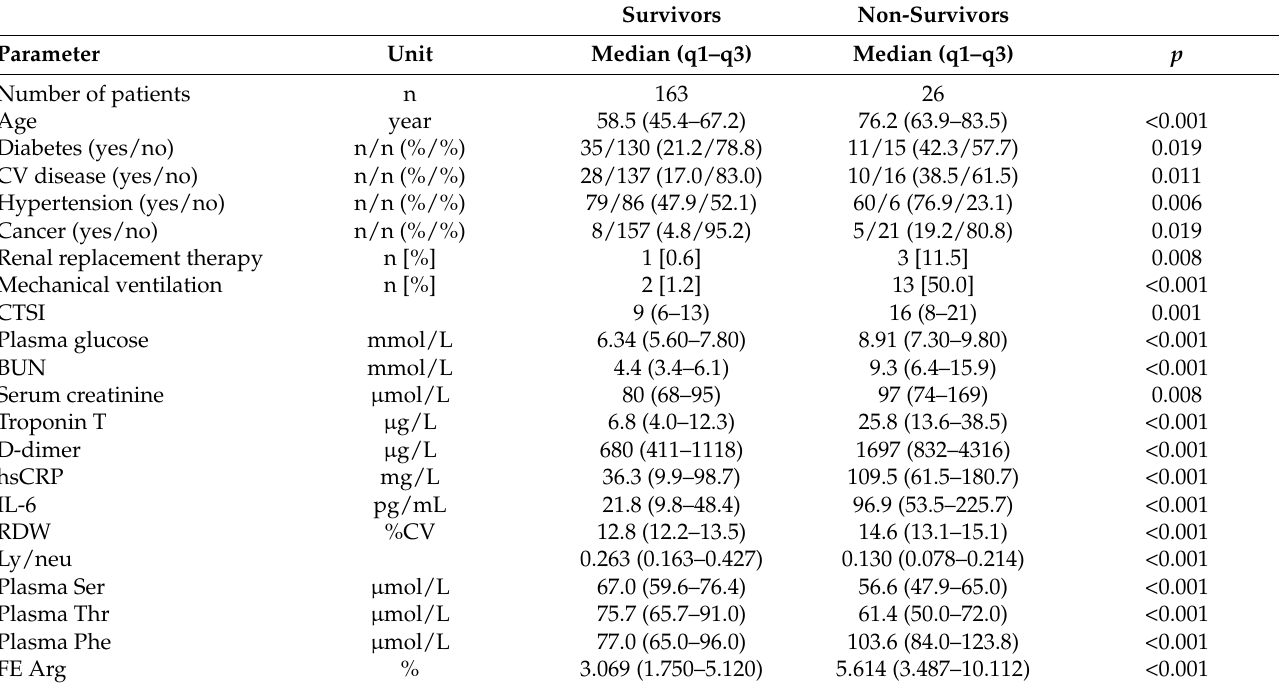
Table 1. Characteristics of study population by survival state. Only parameters with a significant difference between the groups are shown here. All other parameters are listed in Supplementary Table